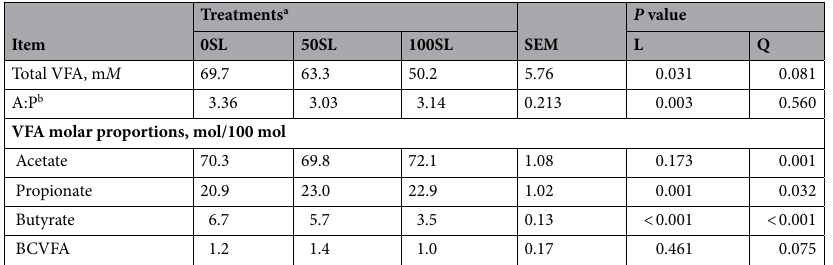
Table 2. Total volatile fatty acids (VFA) and VFA profile of in vitro fermentation from Trial 1. SEM, standard error of the mean; L, linear effect of SL inclusion; Q, quadratic effect of SL inclusion; BCVFA, branched- chain volatile fatty acids = isobutyrate + isovalerate + 2-methylbutyrate. a SL: sericea lespedeza [ Lespedeza cuneata (Dum. Cours.) G. Don] 0SL: 0% (fresh weight basis) SL hay (100% bermudagrass hay); 50SL: 50% SL hay + 50% bermudagrass hay; 100SL: 100% SL hay (0% bermudagrass hay). b Acetate:propionate